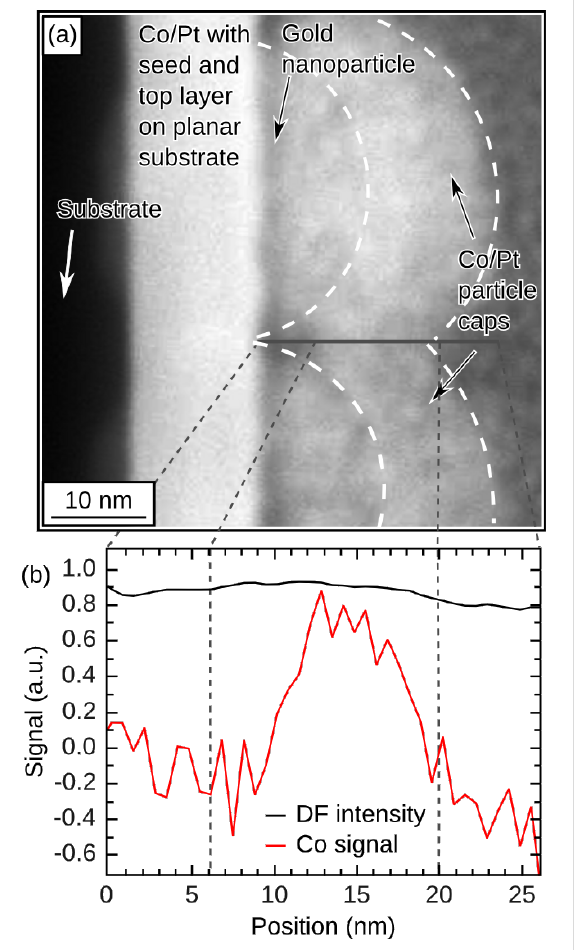
Figure 8: (a) DF-STEM image of 40 nm Au nanoparticles capped with a magnetic Co/Pt multilayer. Panel (b) shows an EELS line scan taken at the contact region between the two particles along the solid line shown in (a). The figure has been reproduced with permission from reference [29] – Copyright 2009